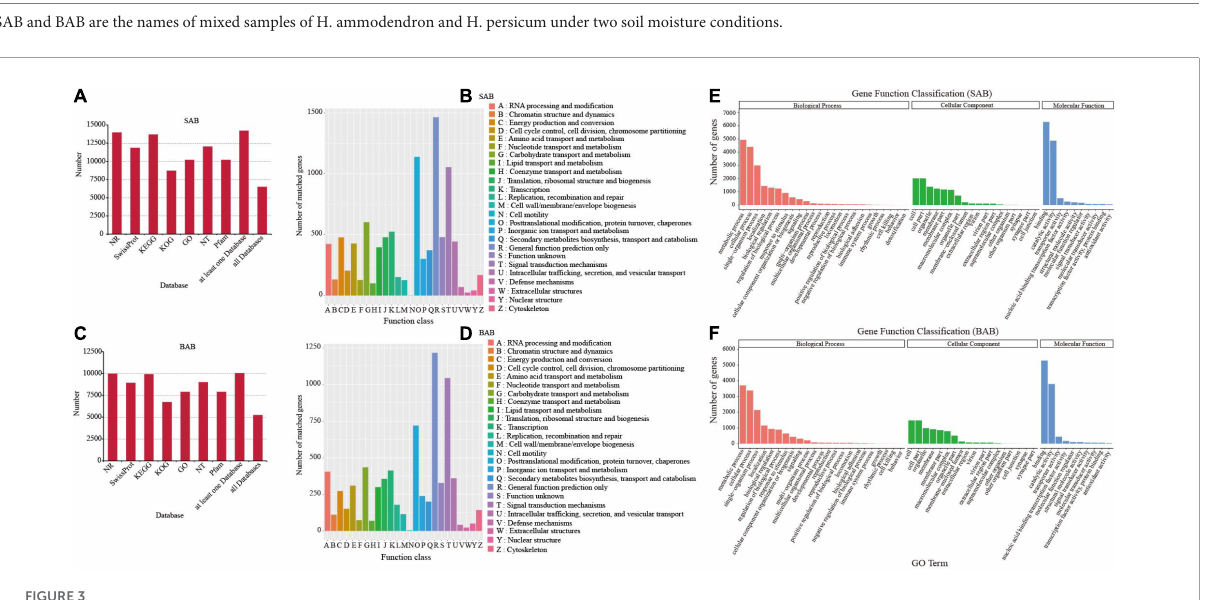
MISA software. Totals of 9,794 and 7,330 SSR repeats